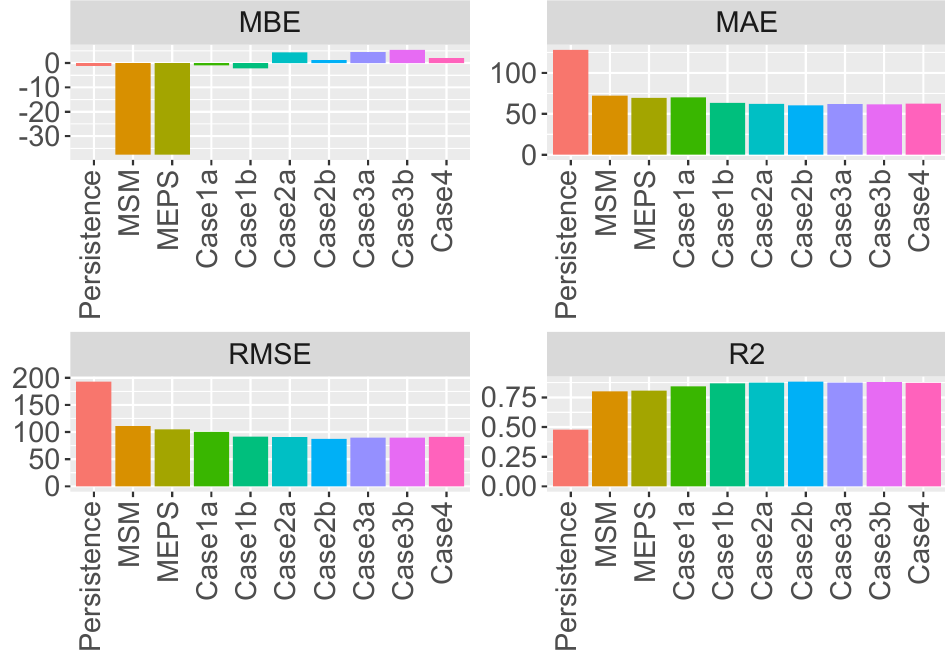
Figure 7. Index of the precision of the